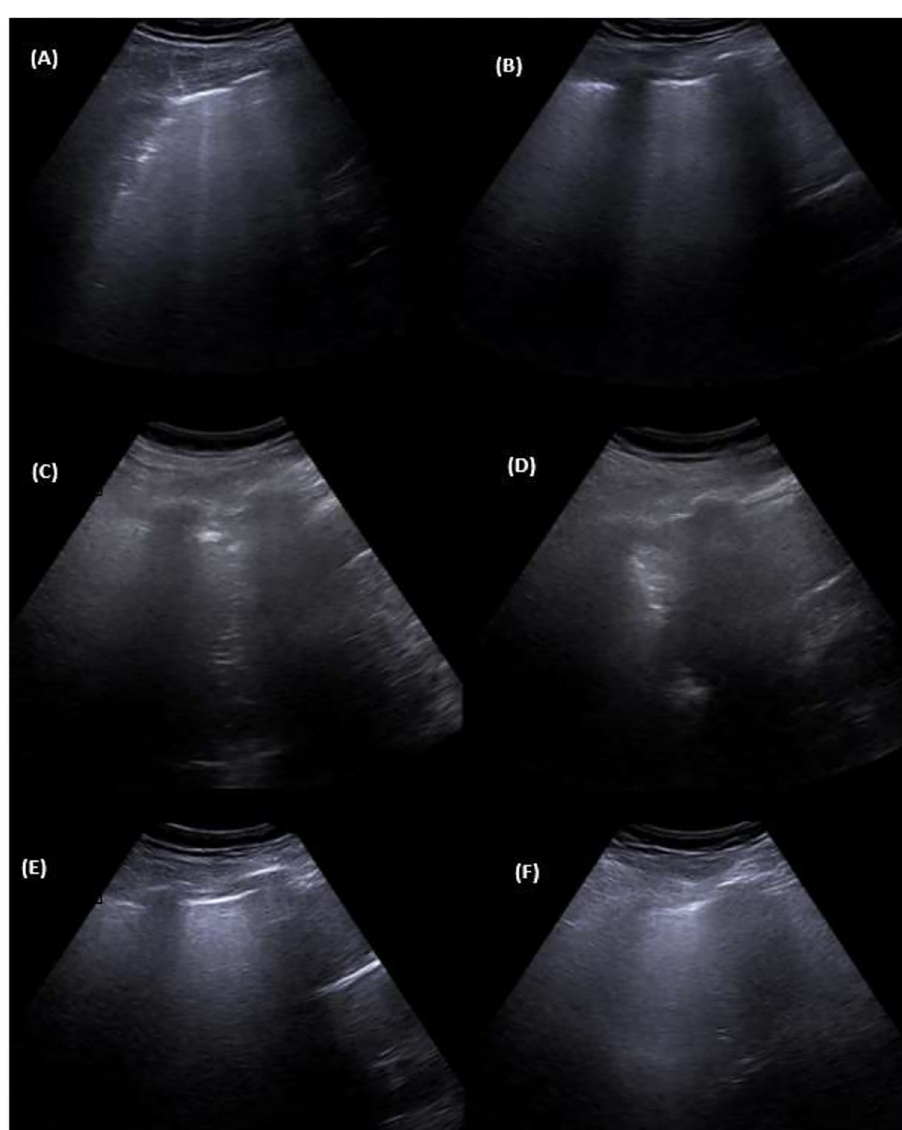
Fig 3. Course of LUS. (A) and (B): d1, LUS 12 points. (A) d1, position L4. (B) d1, position R4. (C) and (D): d7, LUS 16 points. (C) d7, position L4. (D) d7, position R4. (E) and (F): d15, LUS 7 points. (E) d15, position L4. (F) d15, position R4.